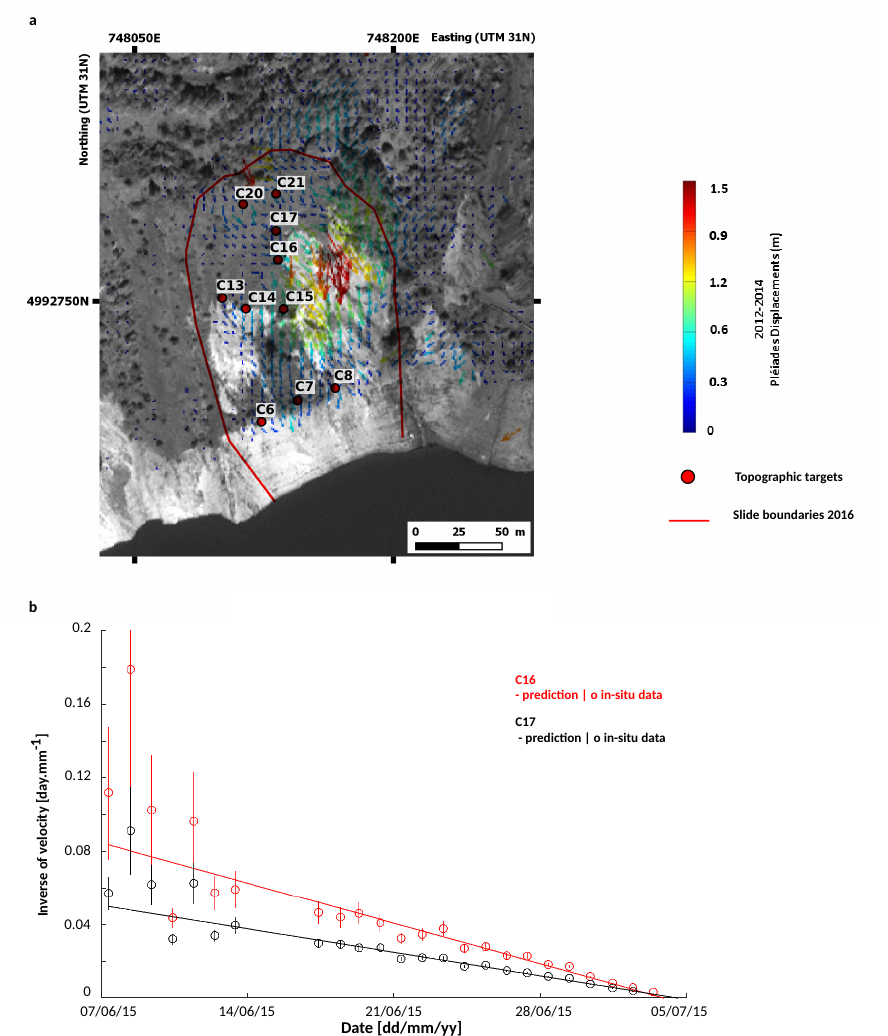
Figure 6. Displacements preceding the failure. ( a ) Displacement field between September 2012 and September 2014. The arrows show its orientation and the color map indicates its amplitude in meters. The predicted time of slope failure is applied to 10 topographic targets with numeration represented by red circles. ( b ) Inverse of velocity versus time for targets C26 and C17, with the associated standard deviation. For these two targets, the rupture was predicted, respectively, on 3 July and 4 July